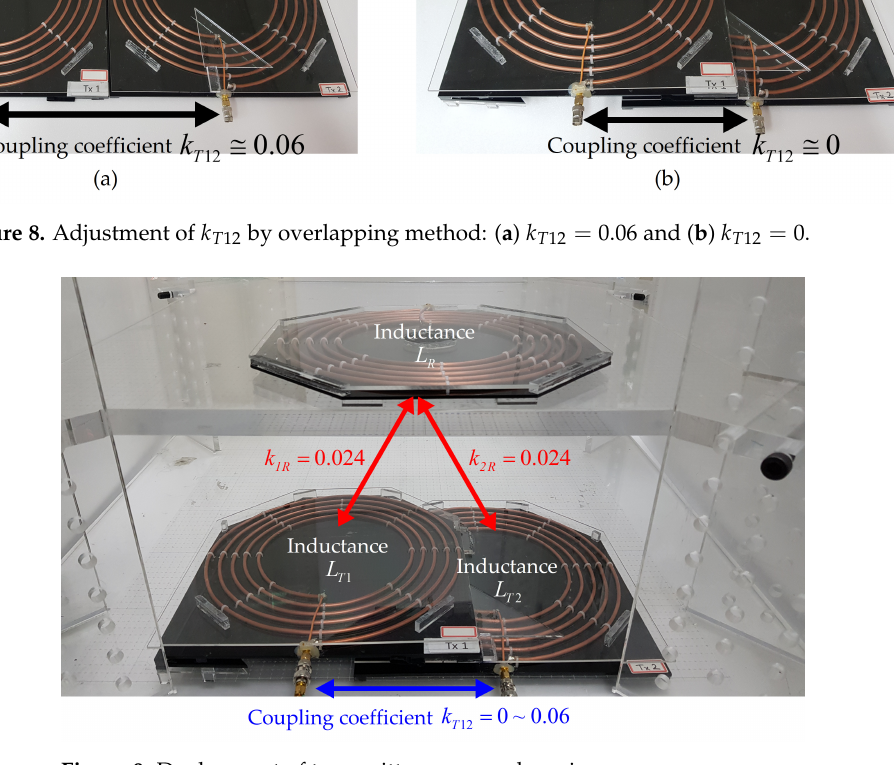
Figure 9. Deployment of transmitter array and